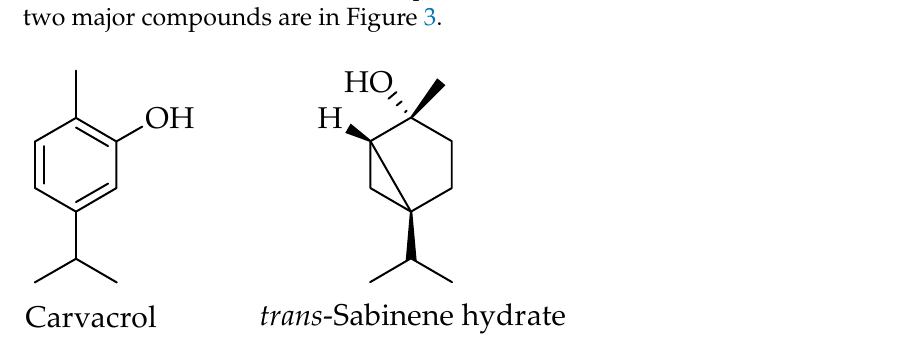
Figure 3. Chemical structures of carvacrol and sabinene hydrate.